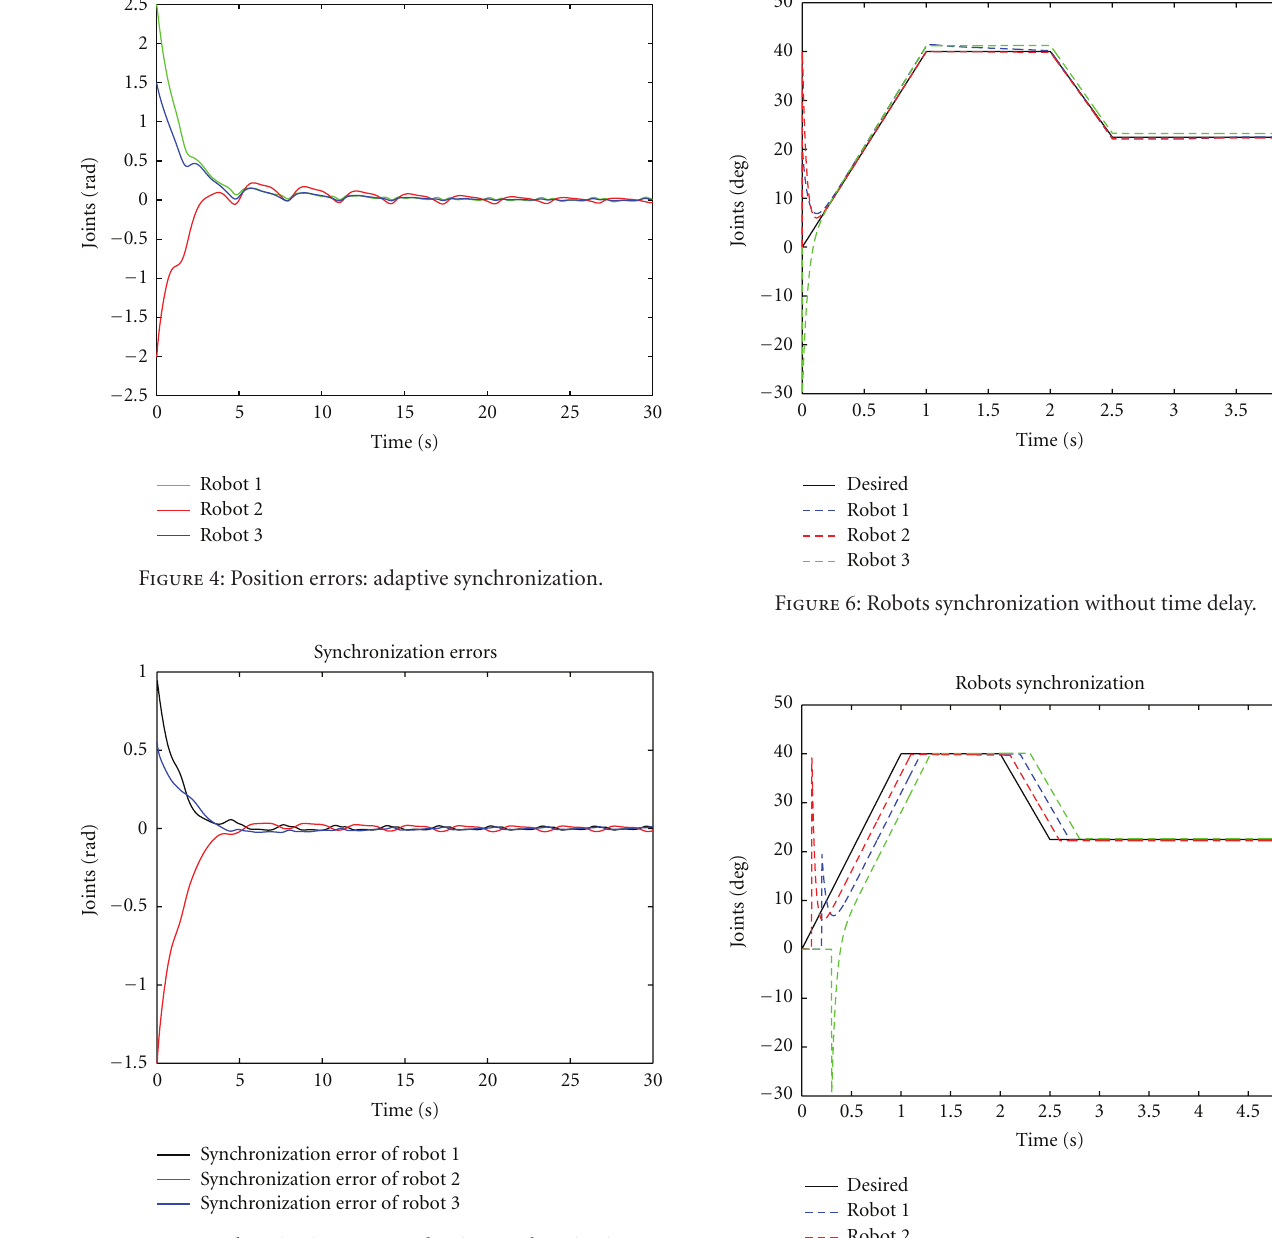
Figure 5: Synchronization errors: adaptive synchronization.